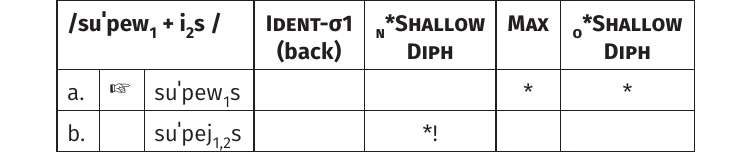
Table 5: A tense stem vowel blocks the selection of a shallow diphthong.